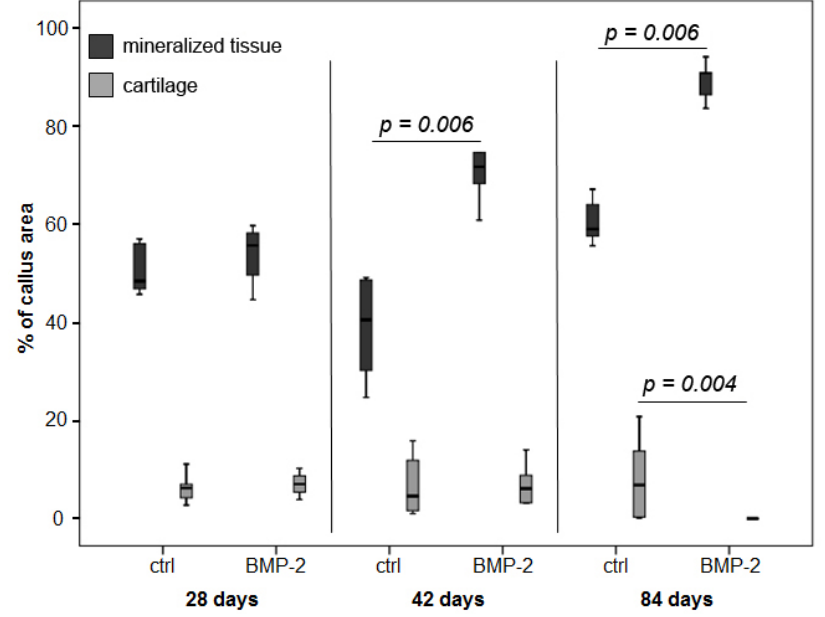
Figure 4. Histomorphometry-based data of the callus composition (mineralized tissue area and cartilage tissue area relative to the total callus area) over time. The mineralization of the callus was significantly enhanced in the BMP-2 group at Days 42 and 84 ( p = 0.006), whereas the cartilage area was significantly reduced after BMP-2 treatment at Day 84 ( p = 0.004).